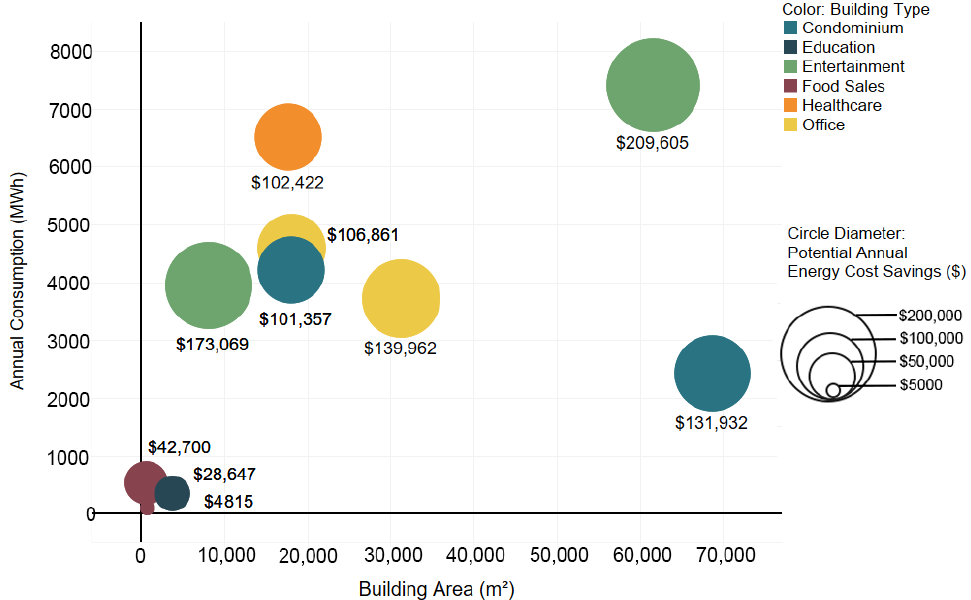
Figure 2. Current annual energy consumption (MWh) vs. building area (m 2 ), with estimated potential annual energy cost savings indicated by size of bubble, and building type indicated by color.